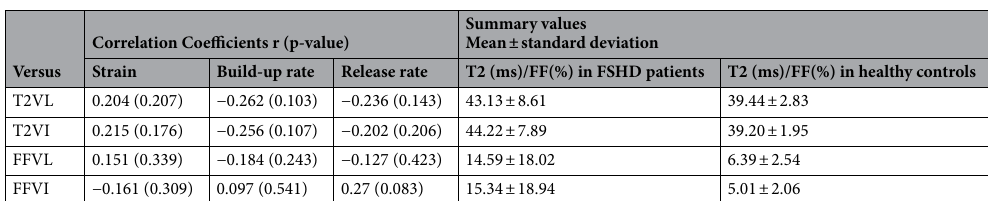
Table 2. Correlation coefficients (r) of the strain (S), build-up (pRT) and release rates (nRT) with water T2 (T2) and fat fraction (FF) in the vastus lateralis (VL) and vastus intermedius (VI). The significance level corrected for multiple comparisons was 0.0042. The number of datasets used were: (FSHD patients: 25 datasets (t0), 17(t1), 9(t2) & healthy controls (7(t0.))).